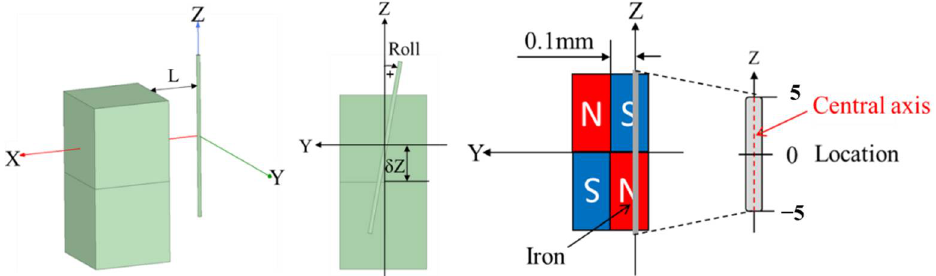
Figure 10. Configuration of Wiegand wire and magnet pair in simulation.